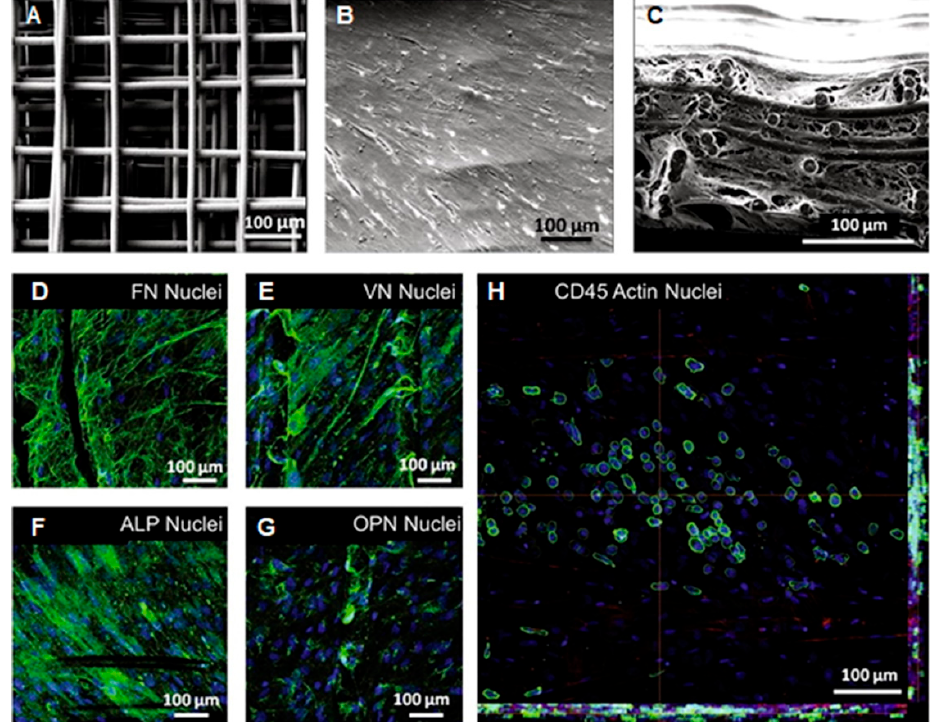
Figure 5. Melt electrospun scaffolds and their effects on human hematopoietic stem cells. ( A ) Melt electrospun PCL scaffolds. ( B ) Scanning electron microscopy (SEM) image of primary human osteoblasts on scaffolds in osteogenic conditions. ( C ) Cross-section profiles of scaffolds seeded with primary human osteoblasts in osteogenic conditions. ( D–G ) The expression of ( D ) fibronectin (FN), ( E ) vitronectin (VN), ( F ) Alkaline phosphatase (ALP), and ( G ) osteopontin (OPN) by primary human osteoblasts in osteogenic conditions. ( H ) Confocal microscopy showed that CD45 + cells (green) attached and migrated into primary human osteoblast-seeded scaffolds using osteogenic conditions (red); cell nuclei in blue. Reproduced from [154] with permission from Elsevier Ltd.; Copyright